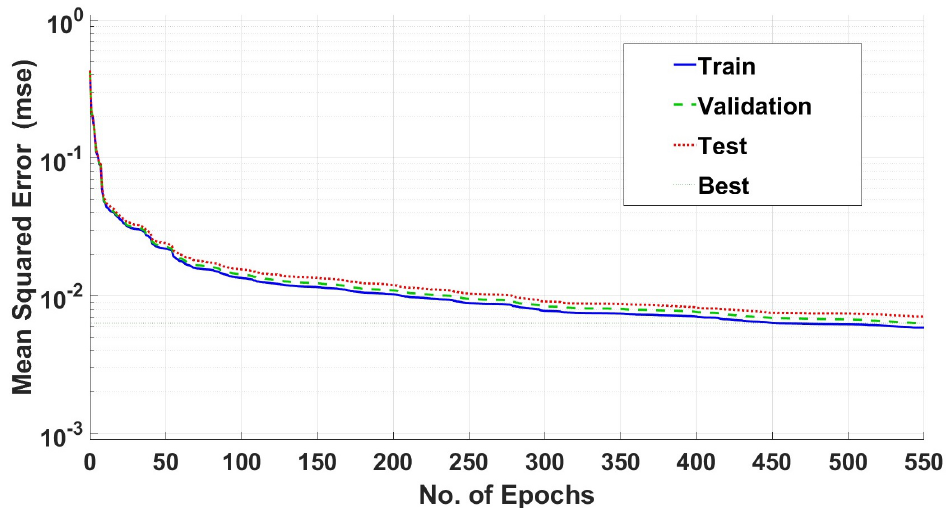
Figure 5. Training performance of LM